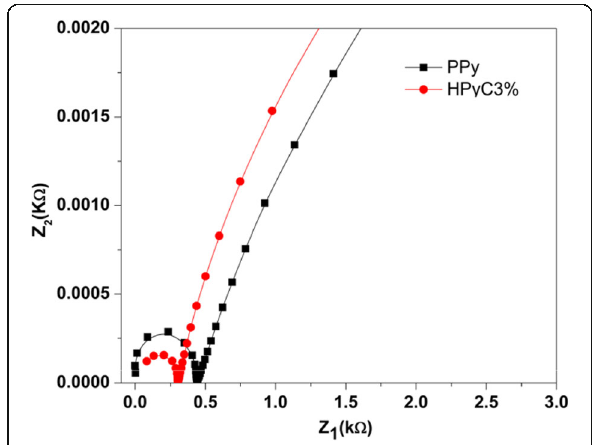
Fig. 7 Nyquist plots of PPy and HPyC3%